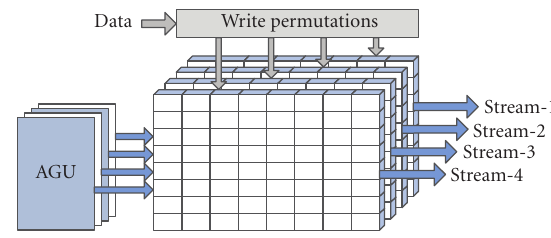
Figure 1: 3D view of interleaver configuration for a multistream communication